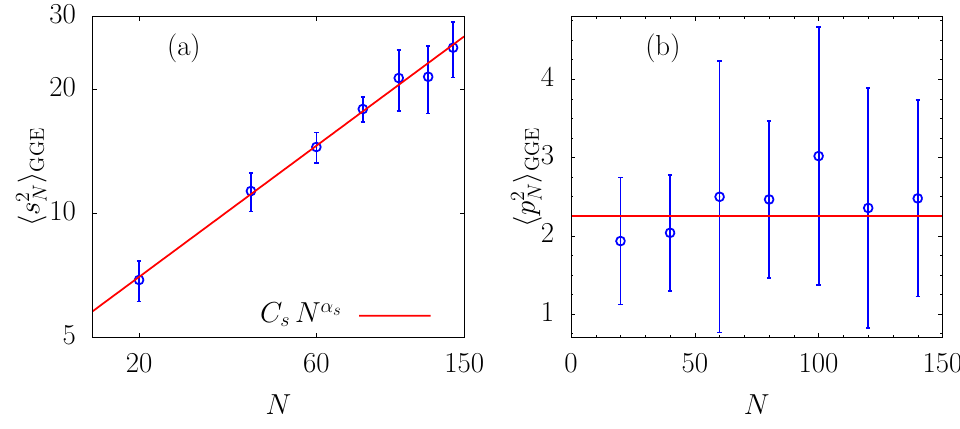
= ( JJ ) 1 / 2 in phase II Figure 6: Finite size dependence on the special curve T 0 0 = 1.5 J 〉 with parameters T and J = 2.25 J . (a) 〈 s 2 , with a power law fit 0 0 0 GGE N = 0.95 and α = 0.66. (b) 〈 p 2 〉 with parameters C and the horizontal line s s GGE N 〈 p 2 〉 = J . Though there are very large error bars, this constant falls well within GGE N them. The results have been averaged over up to 50 different realisations of the harmonic constants and the error bars represent the variance around the